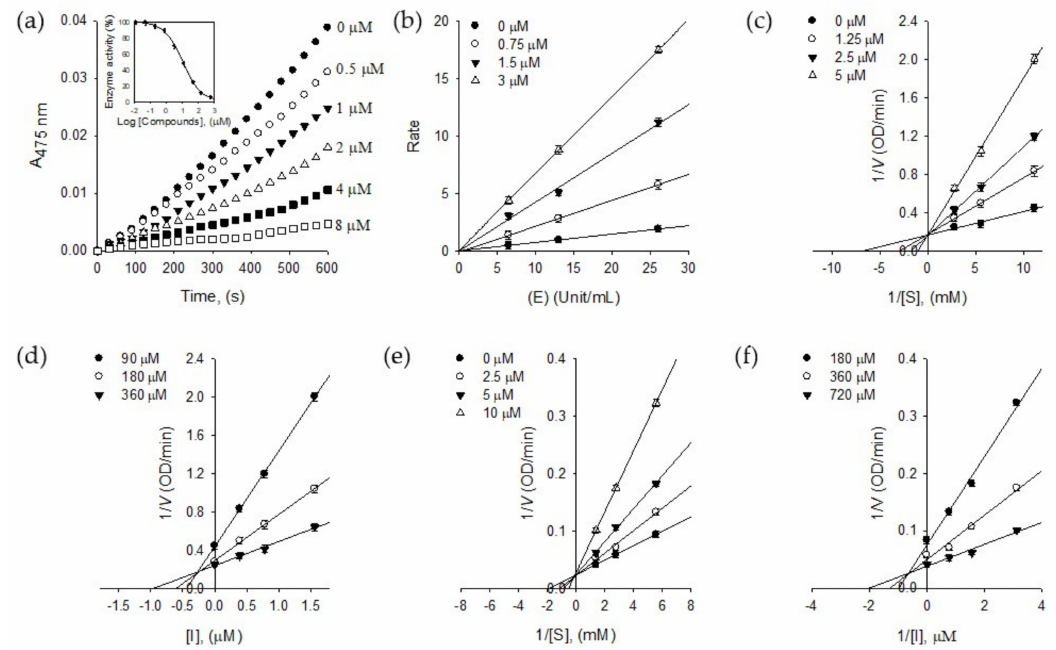
Figure 2. ( a ) Dose-dependent inhibitory e ff ects of isolated compound 1 on monophenolase activity (Inset). The e ff ect of 1 on the activity of monophenolase. ( b ) Determination of the reversible inhibitory mechanism of 1 . ( c ) Lineweaver–Burk plots for the e ff ect of 1 on the monophenolase activity. ( d ) Dixon plots for the e ff ect of 1 on the monophenolase activity. ( e ) Lineweaver–Burk plots for the e ff ect of 1 on the diphenolase activity. ( f ) Dixon plots for the e ff ect of 1 on the diphenolase activity. Table 1. Inhibitory e ff ects of compounds ( 1 and 2 ) on tyrosinase inhibition activity. l -Tyrosine l -DOPA Compound Inhibition Mode Inhibition Mode IC 50 Value ( µ M) IC 50 1 Value ( µ M) ( K i 2 , µ M) ( K i , µ M) 1 2.20 ± 0.2 Competitive (0.87) 3.88 ± 0.3 Competitive (1.95) 2 > 200 NT 3 > 200 NT Kojic acid 4 14.8 ± 0.6 NT 37.1 ± 1.3